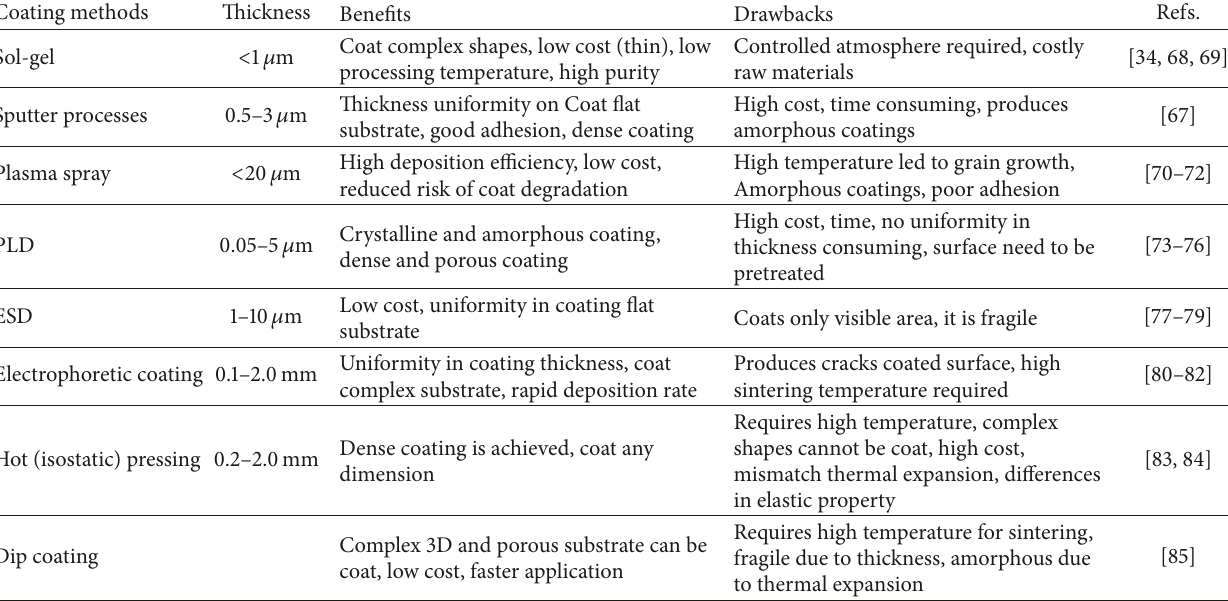
Table 5: Benefits and limitations of CaP-based coating